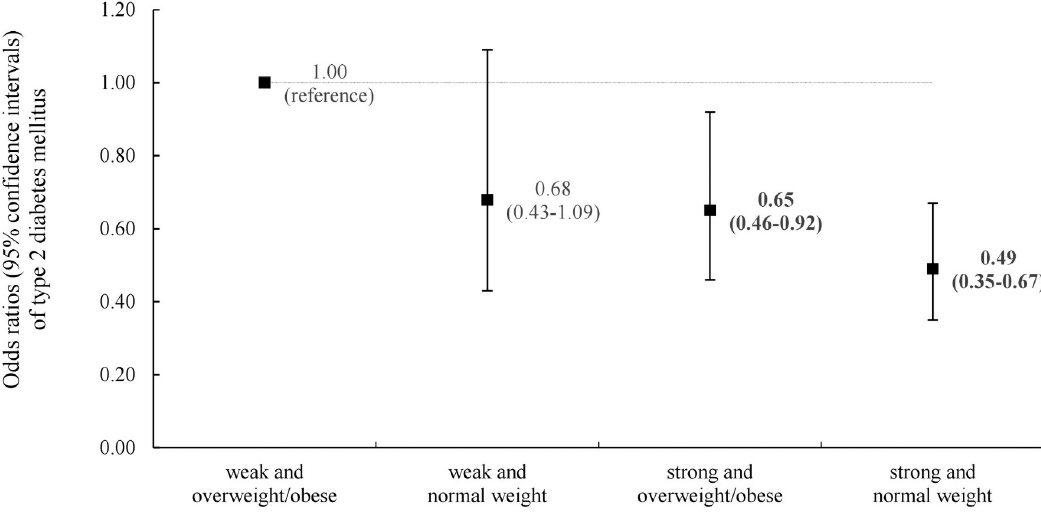
Fig 2. Joint associations of relative grip strength and body mass index with T2DM. Participants were divided into four groups based on combined categories of relative grip strength (weak or strong) and body mass index (normal weight, overweight/obese), respectively. "Weak" was the lower 20% of relative grip strength and "strong" was the upper 80% of relative grip strength. Normal weight was BMI < 25.0kg/m 2 , overweight/obese was BMI � 25.0 kg/m 2 . The model was adjusted for sex, age (years), smoking status (never, former, current), current alcohol drinking (yes or no), regular exercise (yes or no), living with family (yes or no), � high school graduate (yes or no), family history of diabetes (yes or no), hypertension (yes or no), dyslipidemia (yes or no), The number of participants (cases of T2DM) in the “overweight/obese and weak,” “overweight/obese and strong,” “normal weight and weak,”, and “normal weight and strong” groups were 352 (73), 824 (120), 211 (34), and 1,424 (144), respectively.